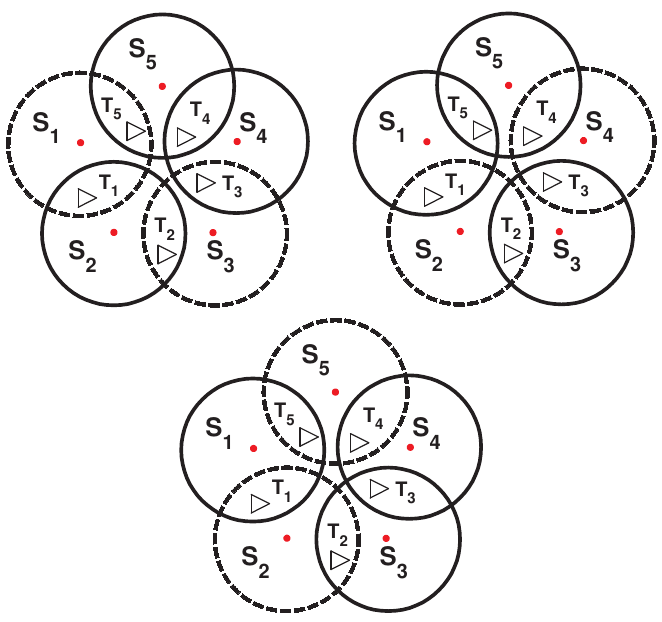
Figure 3. Three non-disjoint cover sets